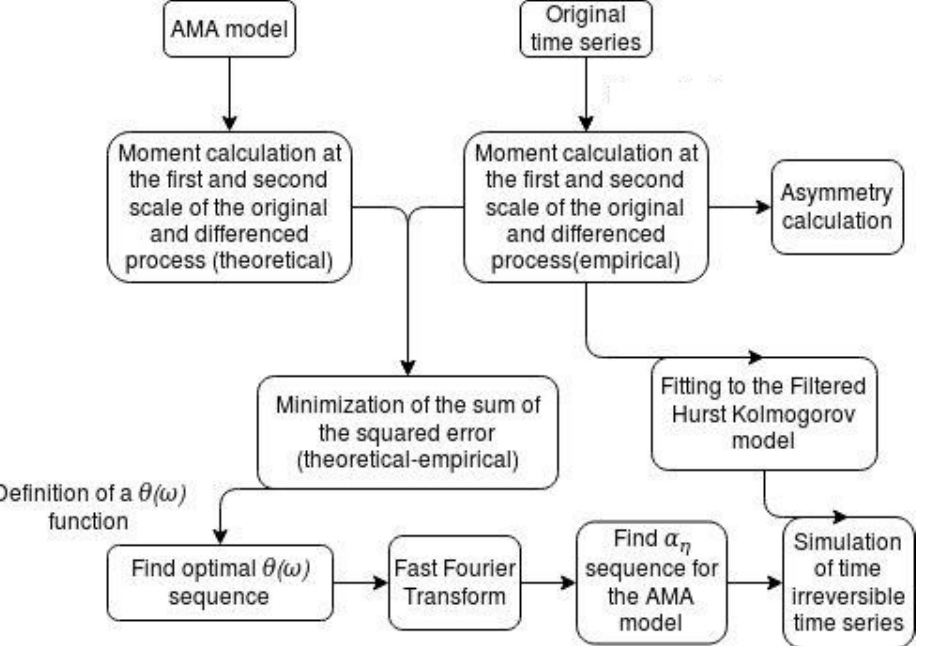
Figure 1. Overview of the simulation methodology (AMA stands for the Asymmetric Moving Average scheme).